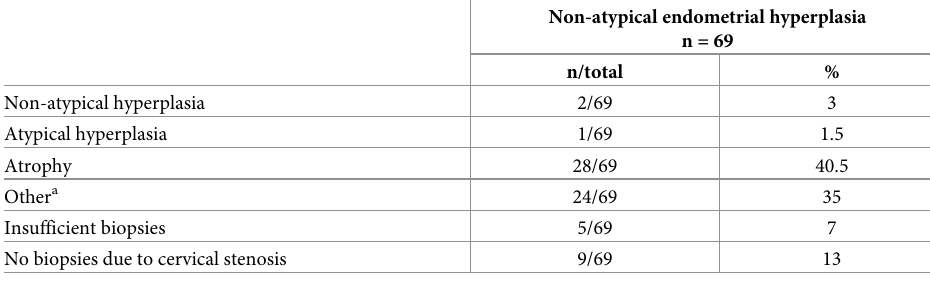
Table 1. Results of biopsies from office mini-hysteroscopy at